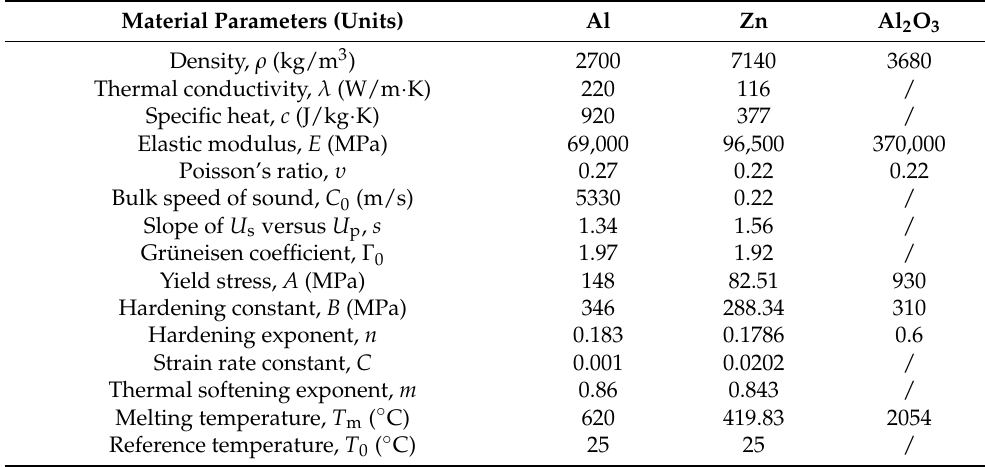
Table 4. The material parameters of microscopic